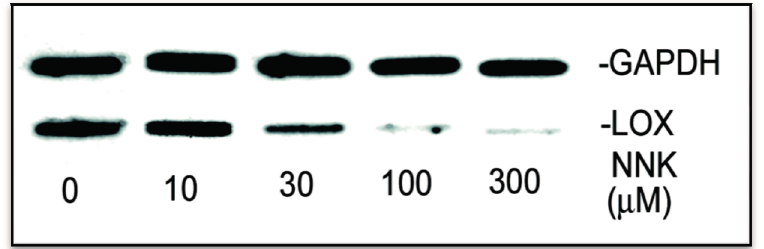
Figure 4. Reduction of the relative transcription rate of LOX in NNK treated cells revealed by the nuclear run-on assay. Nuclei were freshly isolated from growth-arrested control and treated cells under the same conditions as described in the Experimental. Nascent transcripts were labeled with 32 P-UTP and hybridized to a previously prepared filter containing cDNAs for LOX and GAPDH (an internal control). Hybridized radiolabeled RNAs onto filters were washed, dried and autoradiographed on preflashed film.